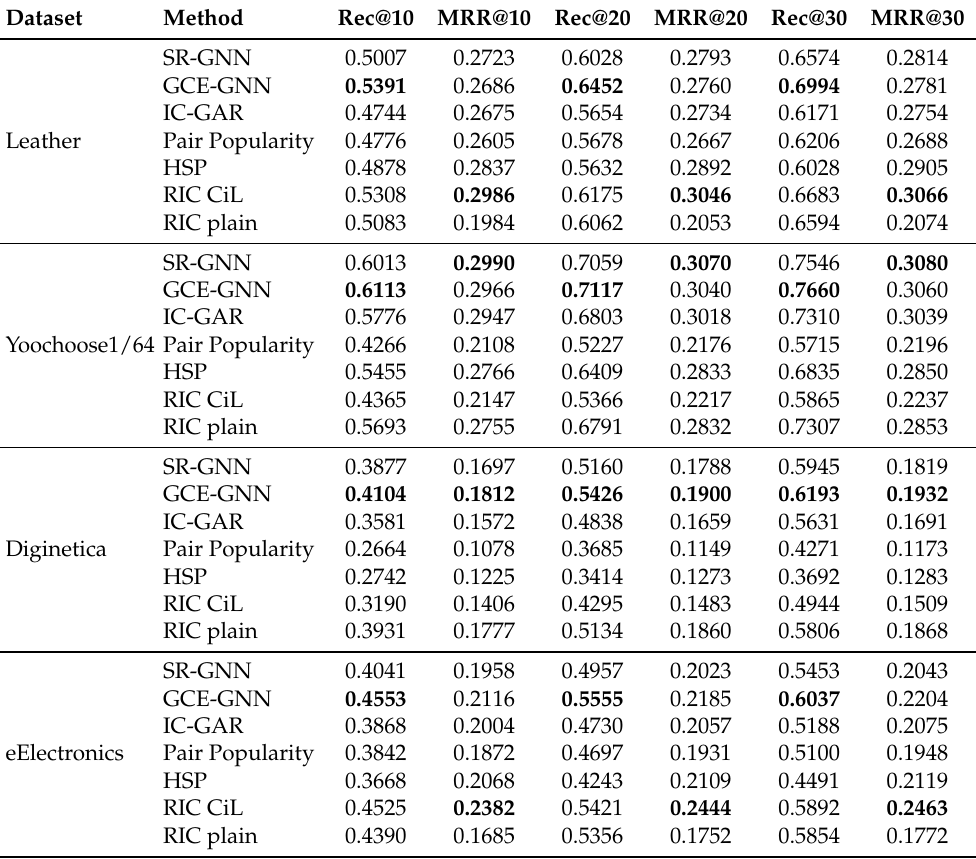
Table 4. Comparison results of our methods against three state-of-the-art Graph Neural Network recommendation models. The MRR@{10,20,30} and Recall@{10,20,30} are used as evaluation metrics. The best performance for each dataset and corresponding metric is marked by bold-face numbers.